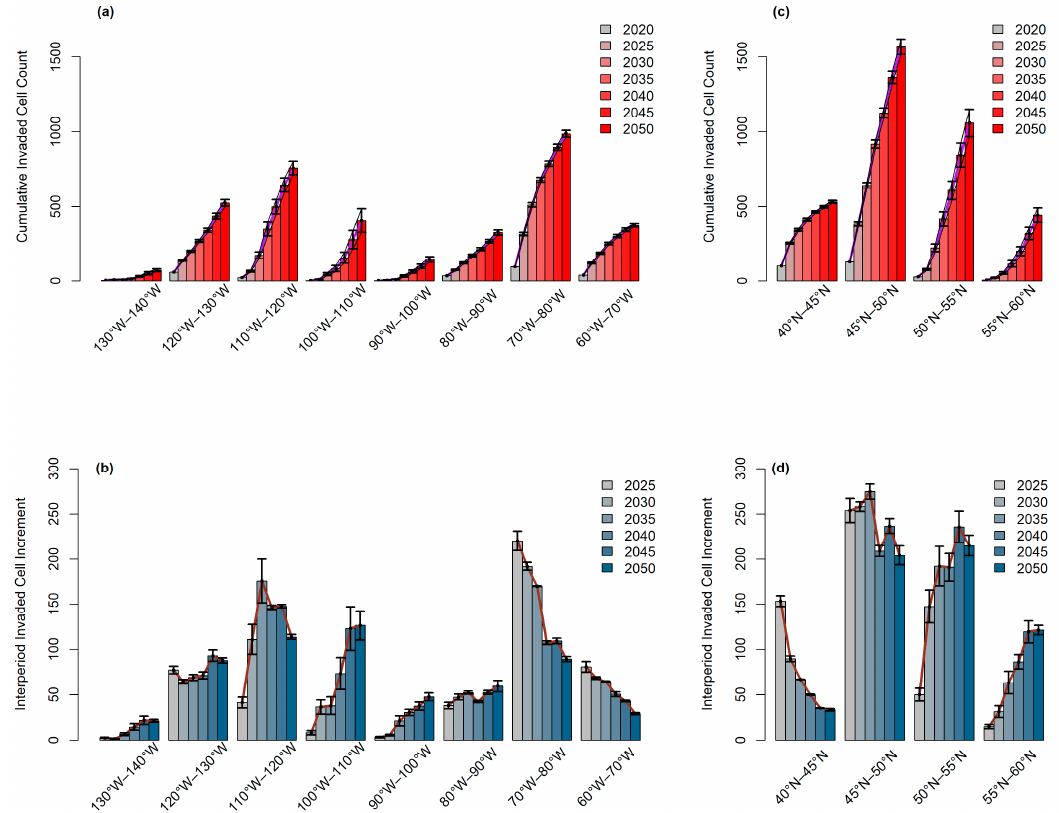
Figure 5. Invaded Cell Counts (ICC) and Interperiod Invaded Cell Increment (IPI) of 10 ◦ Longitudinal and 5 ◦ latitudinal bands for 5-year periods. ( a ) ICC of 10 ◦ longitudinal bands, ( b ) IPI of 10 ◦ longitudinal bands, ( c ) ICC of 5 ◦ latitudinal bands, ( d ) IPI of 5 ◦ latitudinal bands.